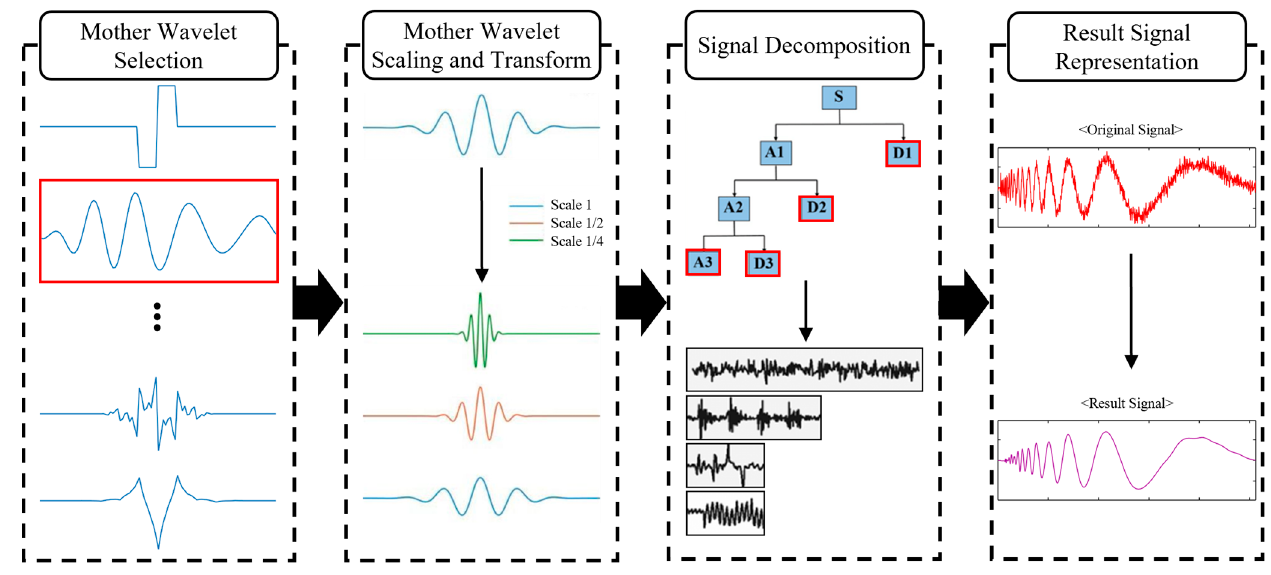
Figure 3. Overall procedure of wavelet transform.